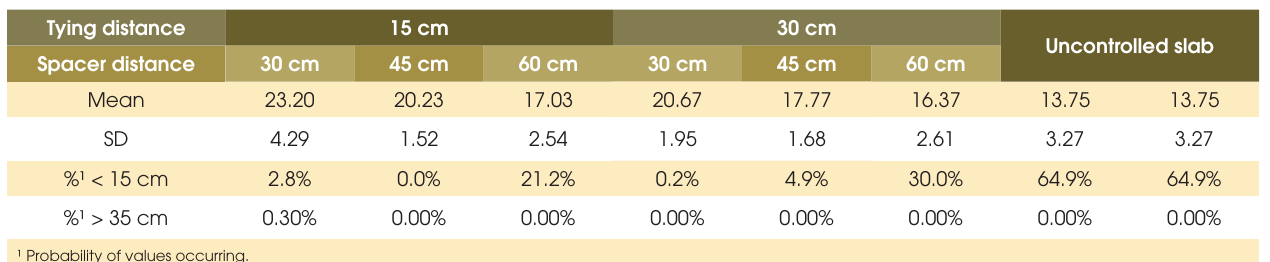
Table 5 – Occurrence of non-compliant